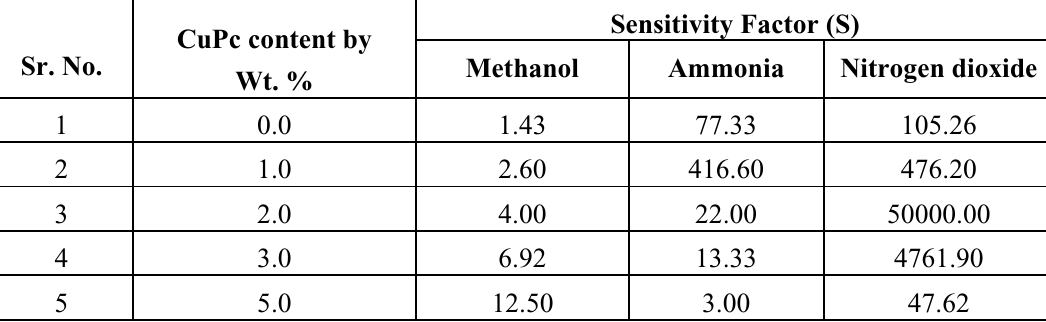
Table 3. Sensitivity of PT-CuPc polymers with chemical